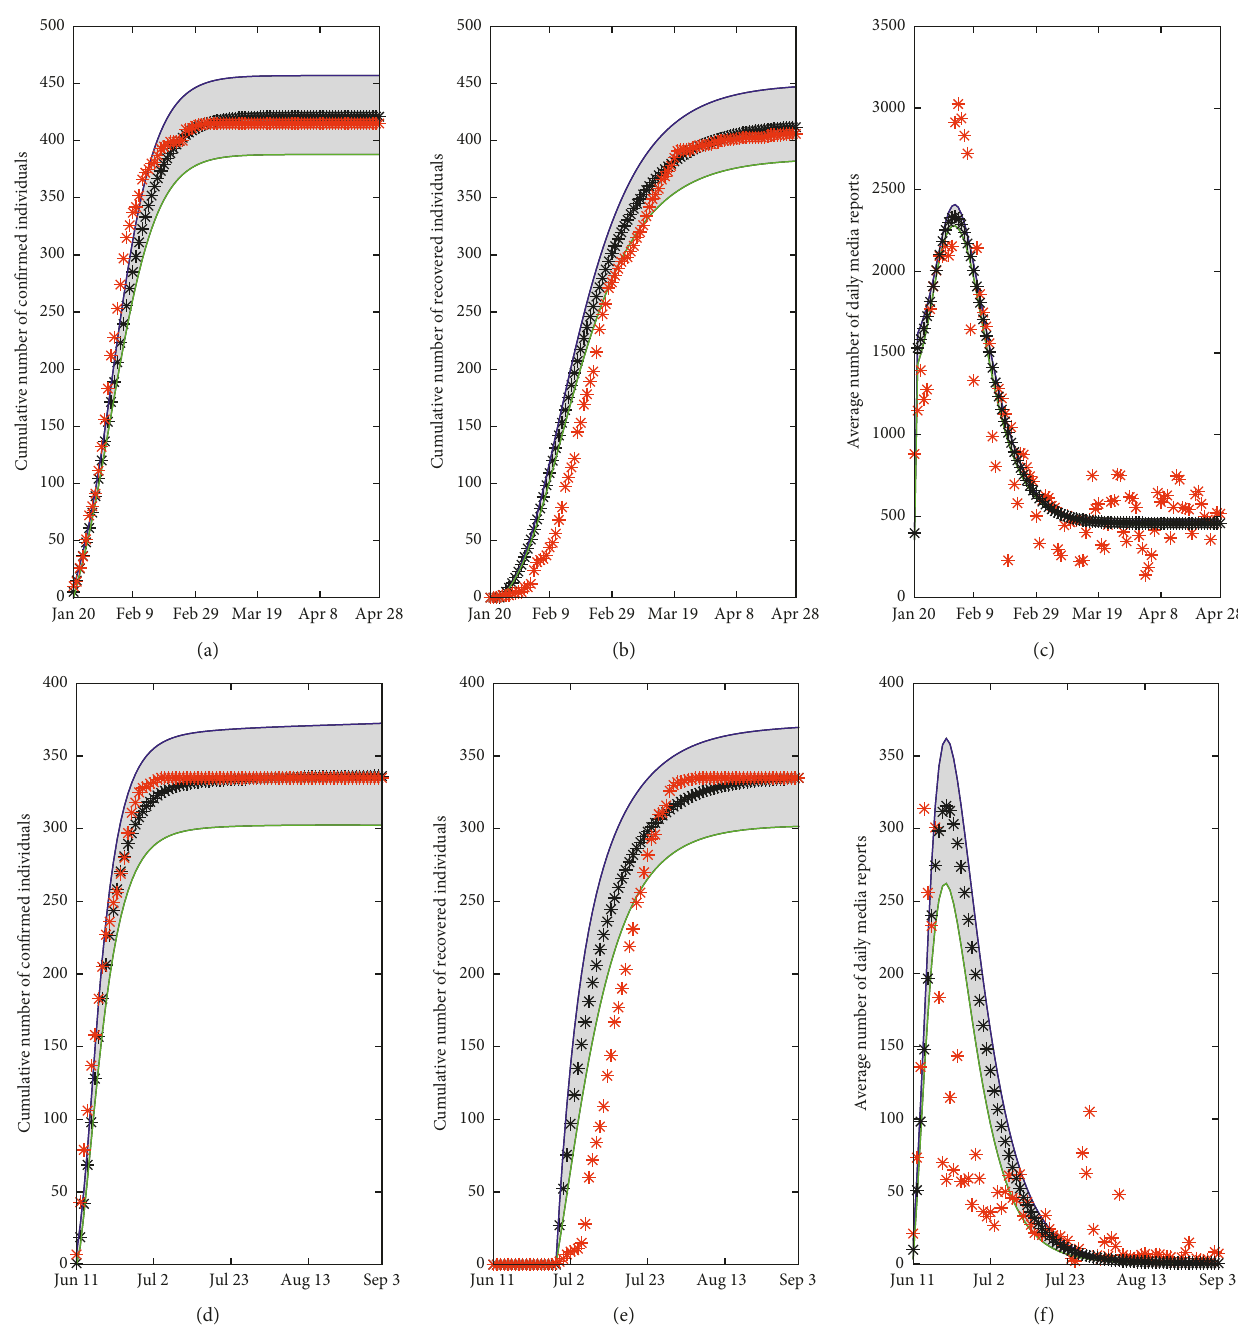
Figure 5: Fitting result for the Beijing data from (a)–(c) 20 January to 28 April 2020 and (d)–(f) 11 June to 3 September 2020. The red asterisks are the cumulative number of confirmed cases, recovered cases, and average daily number of media reports, respectively. The black asterisks are the best-fitting result. The grey region represents the 95% confidence intervals with the blue/green curves representing the 95% upper/lower confident